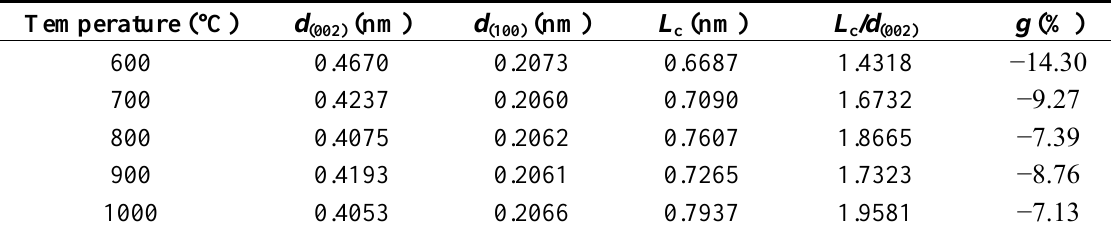
Table 1. Structure parameters of X-ray diffraction for